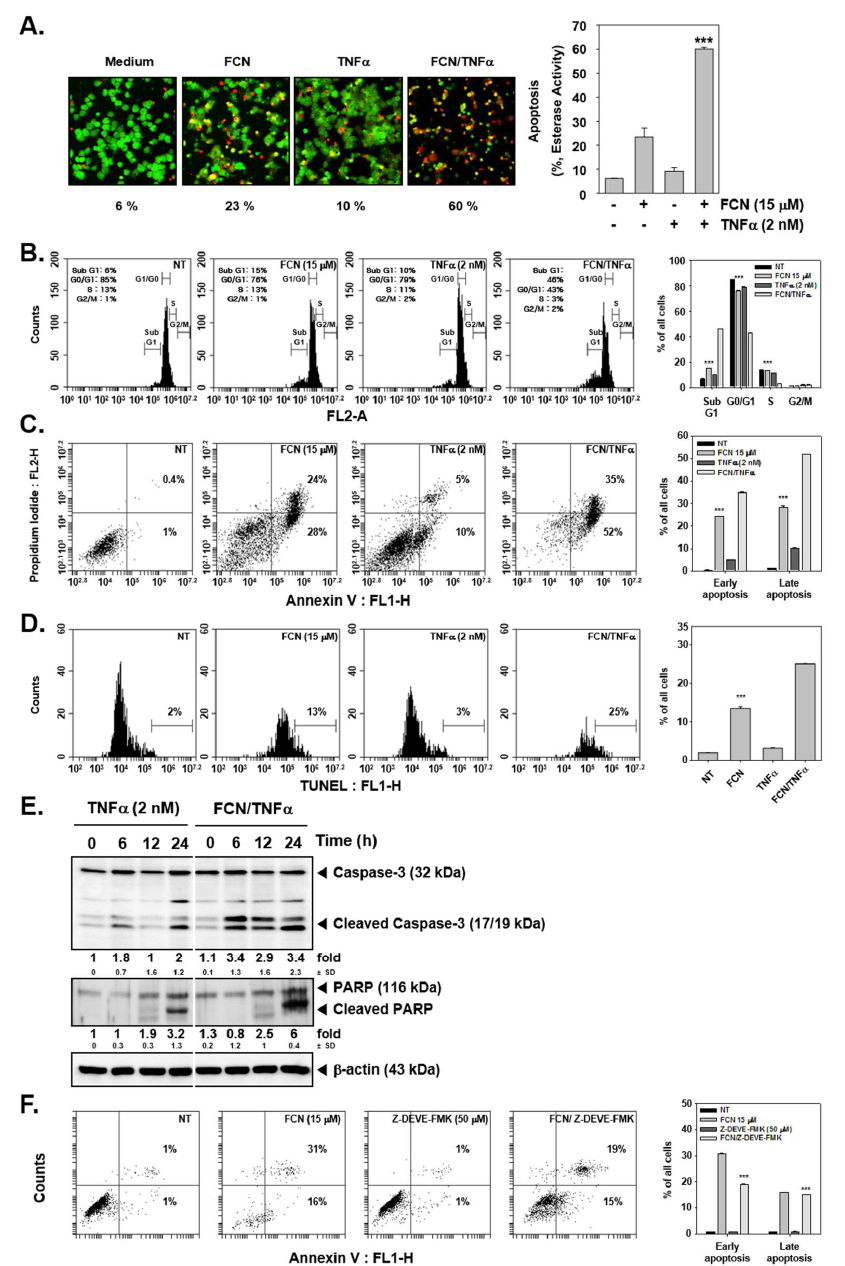
Figure 4. FCN can augment cytokine caused apoptosis. KBM5 cells were pre-treated with 15 µ M of FCN and 2 nM TNF α was thereafter added for a total of 24 h. ( A ) Cytotoxicity of FCN and TNF α was analyzed by live and dead assay. Live cells were stained with Calcein AM (green) and dead cells were stained with Ethd-1 (red). The graph ( right) shows the rate of dead cells by quantification. ( B ) Cells were treated as described above and then fixed with EtOH overnight. RNase A (10 µ g / mL) was treated for 1 h and then cells were stained with propidium iodide, analyzed by flow cytometry. ( C ) FCN and TNF α treated cells were stained with Annexin V Fluorescein isothiocyanate (FITC) / propidium iodide, and analyzed by flow cytometry. ( D ) After FCN and TNF α treatment, cells were subjected to Terminal deoxynucleotidyl transferase dUTP nick end labeling (TUNEL) assay. ( E ) KBM5 cells were treated as described above and Western blot analysis was performed. ( F ) KBM5 cell were treated with FCN (15 µ M) and Z-Asp(O-Me)-Glu(O-Me)-Val-Asp(O-Me) fluoromethyl ketone (Z-DEVD-FMK) (50 µ M, caspase inhibitor) for 24 h. Cells were stained with Annexin V FITC / propidium iodide and then analyzed by flow cytometry. The results shown are representative at least three independent